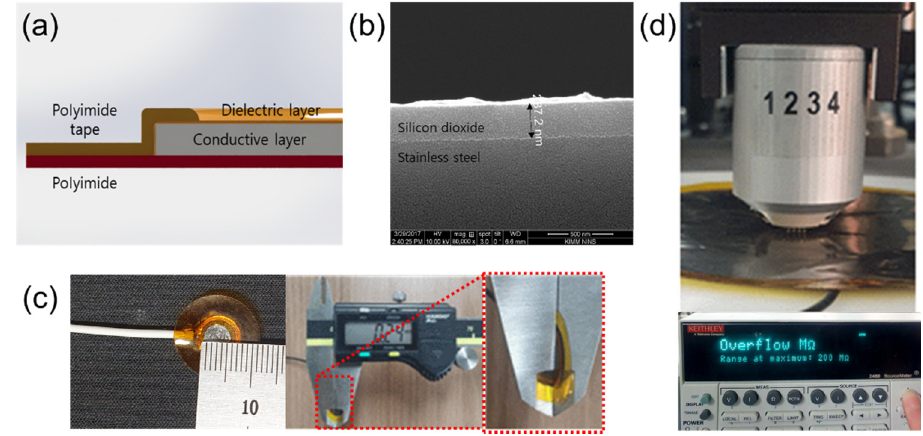
Figure 3. Silicon − dioxide − coated capacitive − coupled electrode. ( a ) Structure schematic of the capacitive − coupled electrode. ( b ) SEM (Fei company, Nova 200 NanoLab) picture of silicon dioxide. ( c ) Fabricated electrode (diameter: 0.5cm) and total thickness (240 µ m). ( d ) Surface resistance measurement of capacitive − coupled electrode using 4 − point probe.